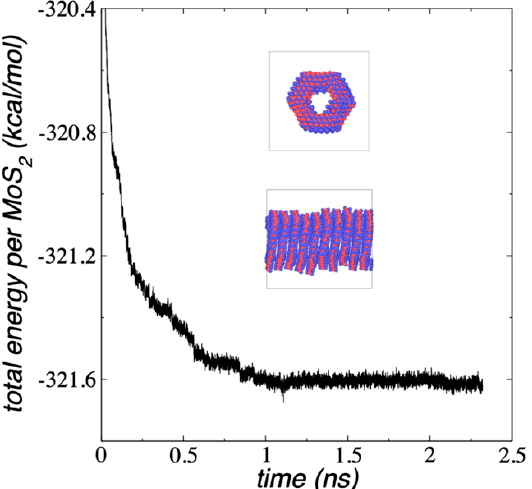
Figure 12. E #MoS2 of the Mo 108 S 216 -Mo 27 S 54 , 10L nanotube with the 3R orientation as a function of the simulation time, under periodic simulation cell and NVT conditions at 298.15 K. The inset snapshots correspond to normal (top) and lateral (bottoms) views of the nanotube. Black lines in the bottom snapshot correspond to the actual limits of the periodic simulation cell. Blue and red spheres represent Mo and S atoms, respectively.